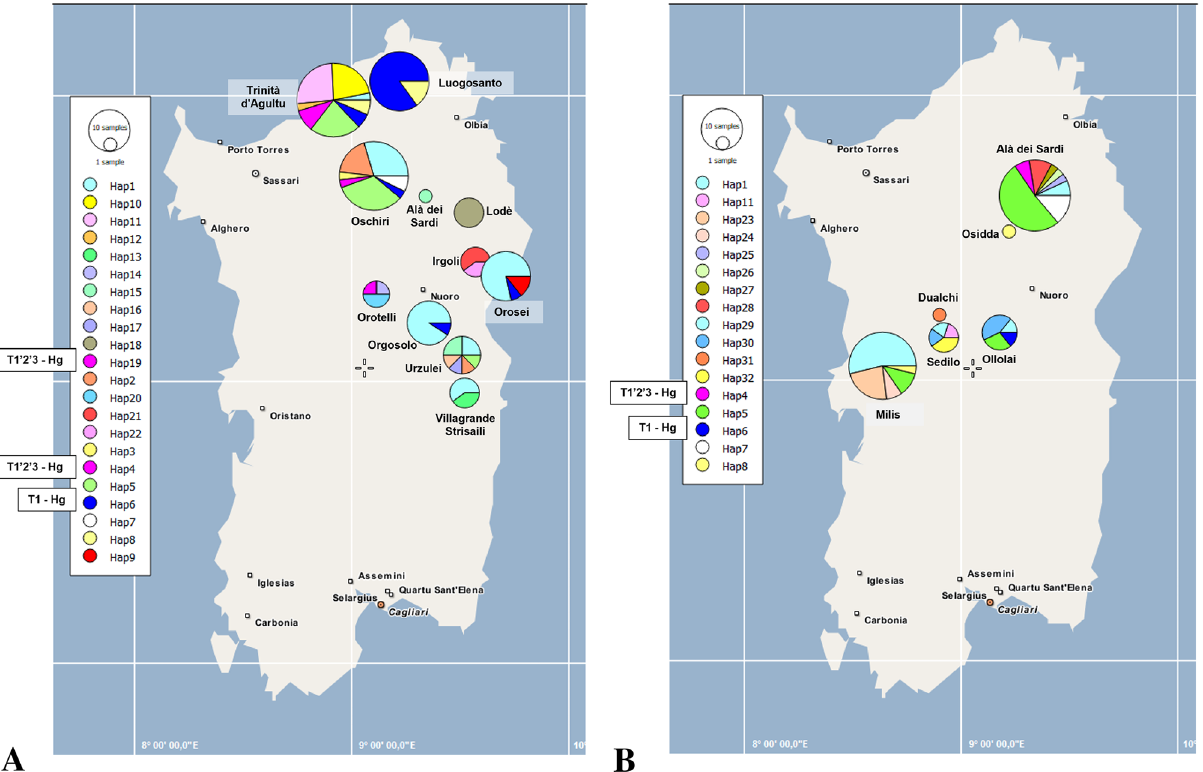
Figure 1. Geographic distribution of mtDNA haplotypes. The map was created by authors using the PopArt software, version 1.7 (http:// popart. otago. ac. nz/ index. shtml), (Leigh and Bryant, 2015). Pie chart slices are proportional to the frequency of the haplotypes. ( A ) Sampling sites and haplotypes found in the Sarda breed cattle. ( B ) Sampling sites and haplotypes segregating in the Sardo Bruna breed cattle, except for the Milis sampling site, where all animals were of the Sardo Modicana breed. Haplotypes belonging to the T1 haplogroup are indicated in blue (T1 – Hg), Haplotypes of the T1’2’3 haplogroup are indicated in pink (T1’2’3 – Hg), all the other haplotypes were represented with pastel colours, and belong to the T3 haplogroup.